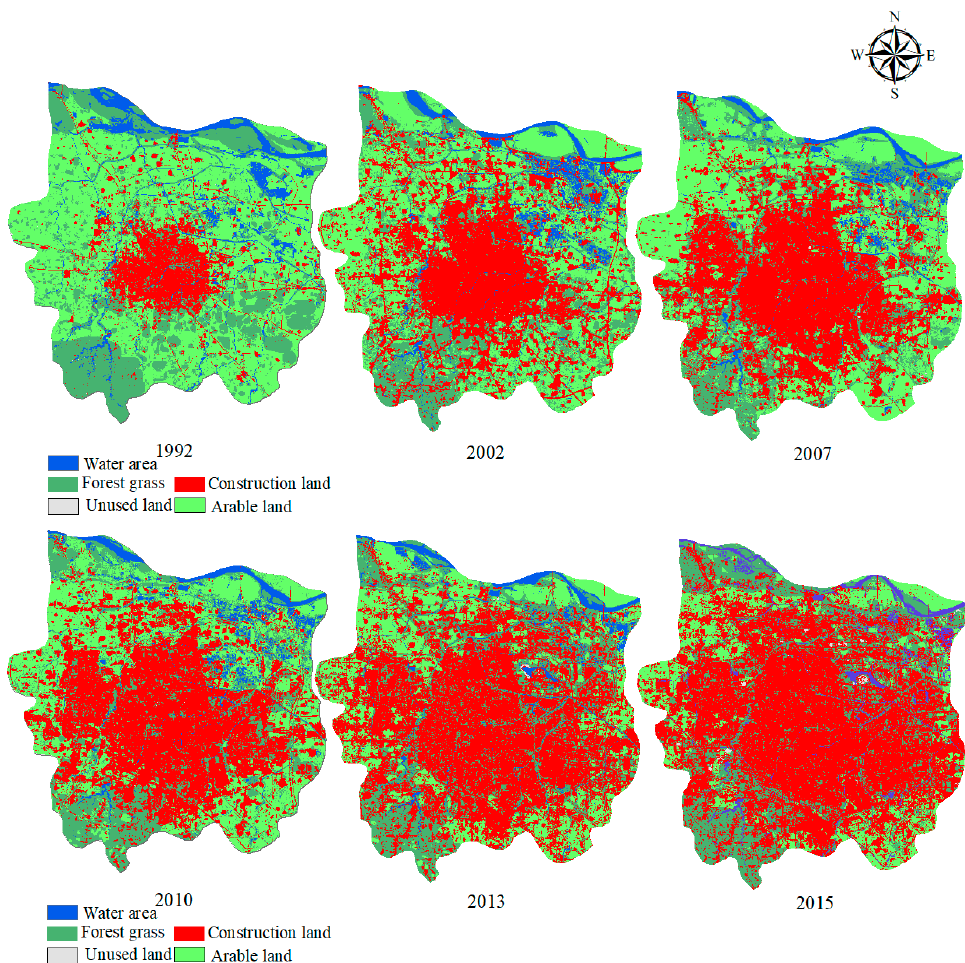
Figure 6. Land-use classification results from the 1992 to 2015 period. Table 7. Characteristic indexes of water system pattern and Pearson analysis of proportion of each land use.